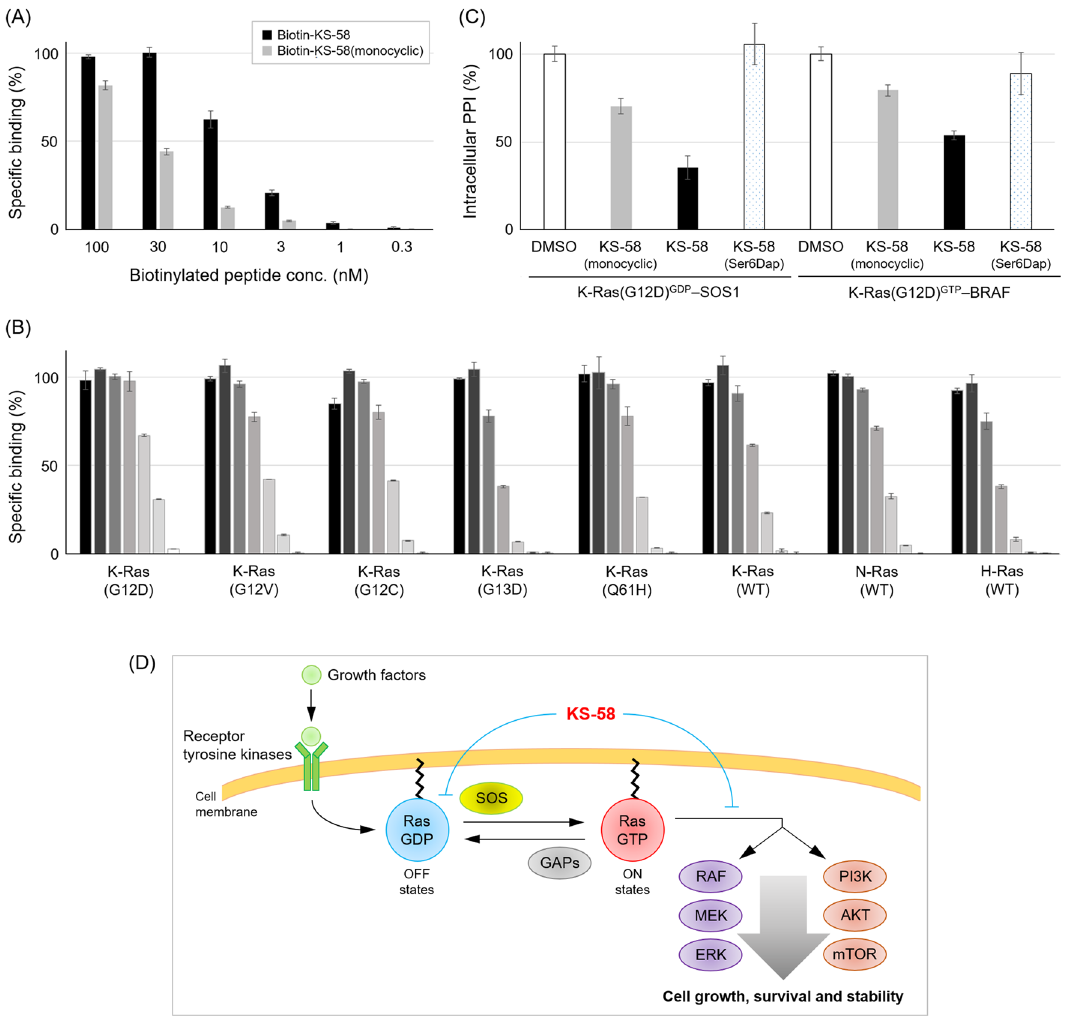
Figure 4. Biochemical characters of KS-58. ( A ) Binding activity of biotinylated peptides to recombinant K-Ras(G12D) protein in ELISA (n = 4, ± SEM). ( B ) Binding activity of different concentrations (from the highest 3 µM and subsequent threefold dilution) of Biotin-KS-58 to recombinant Ras proteins as measured by ELISA (n = 4, ± SEM). ( C ) Inhibition activity of peptides to intracellular Ras–effector proteins interactions. Intracellular PPI in the presence or absence of peptides are detected as luminescence, and the PPI is showed as % value (30 µM, n = 4, ± SEM). ( D ) Proposed K-Ras(G12D)-inhibition mechanism of KS-58.